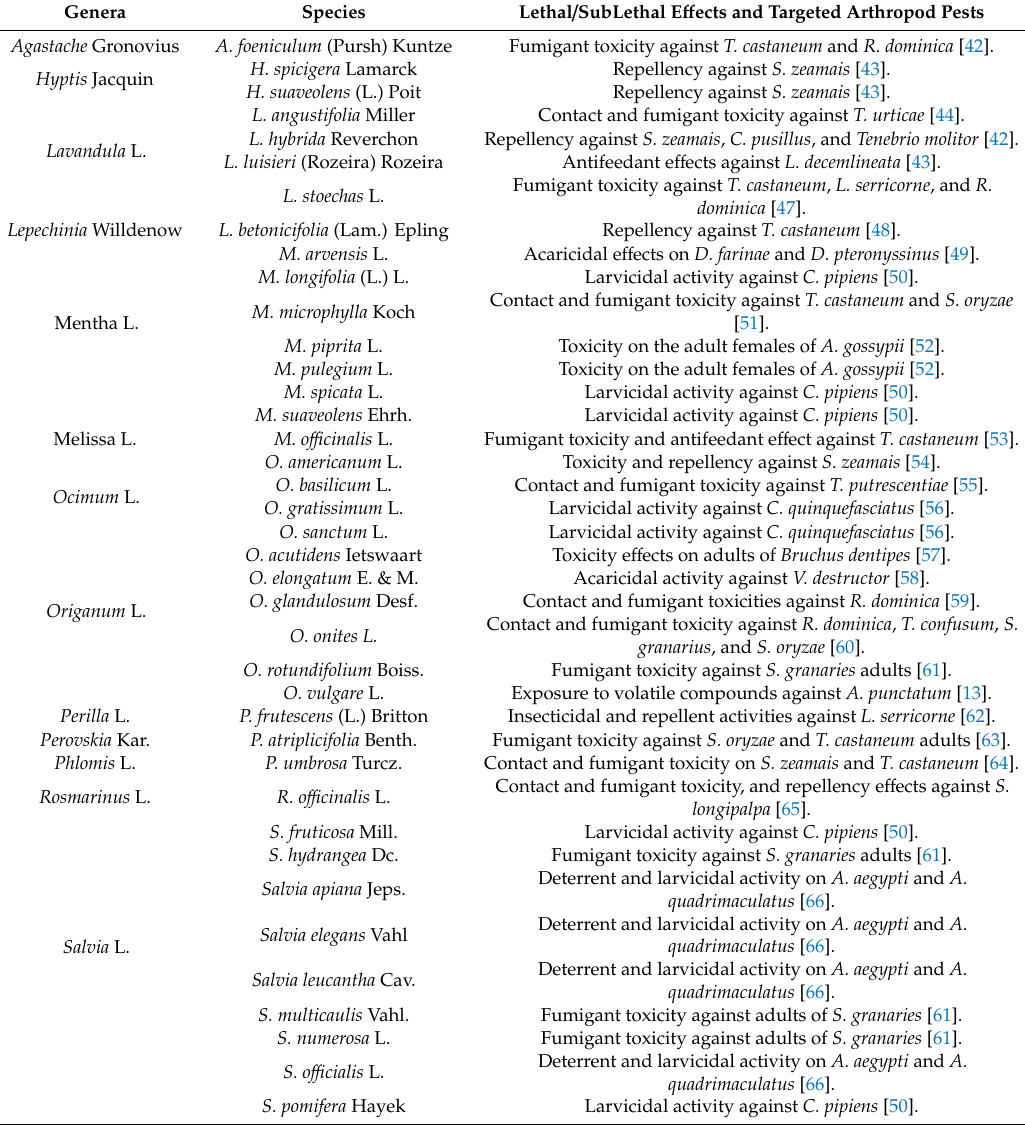
Table 1. A list of reports indicating pesticidal e ff ects of essential oils isolated from the Lamiaceae